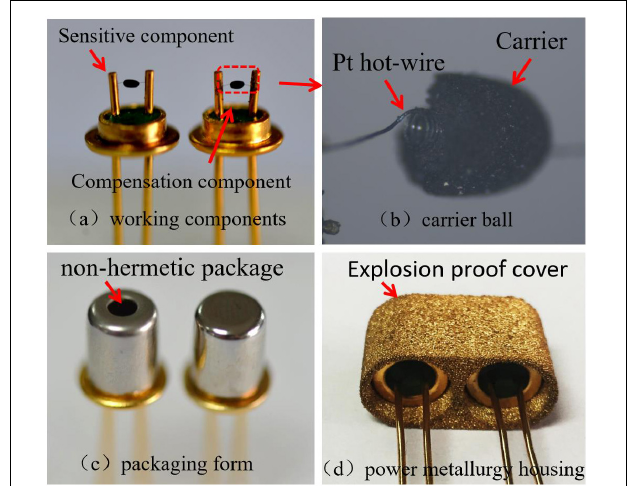
FIGURE 1 | Sensor assembly package. Label (a) shows working components, label (b) shows carrier ball, label (c) shows packaging form, label (d) shows powder metallurgy housing.